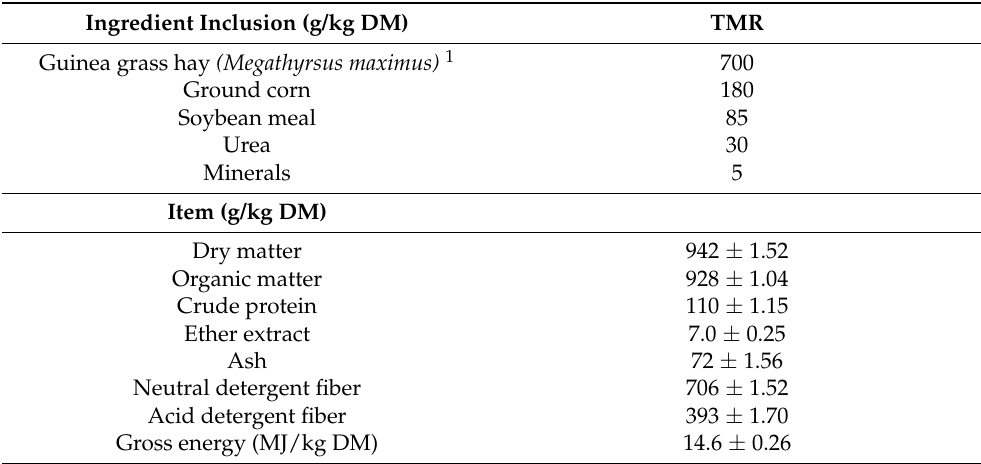
Table 1. Ingredients and composition of the total mixed ration